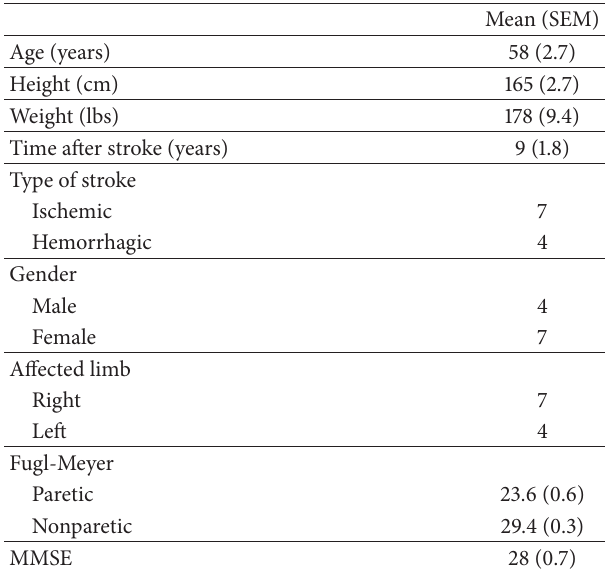
Table 1: Baseline characteristics of